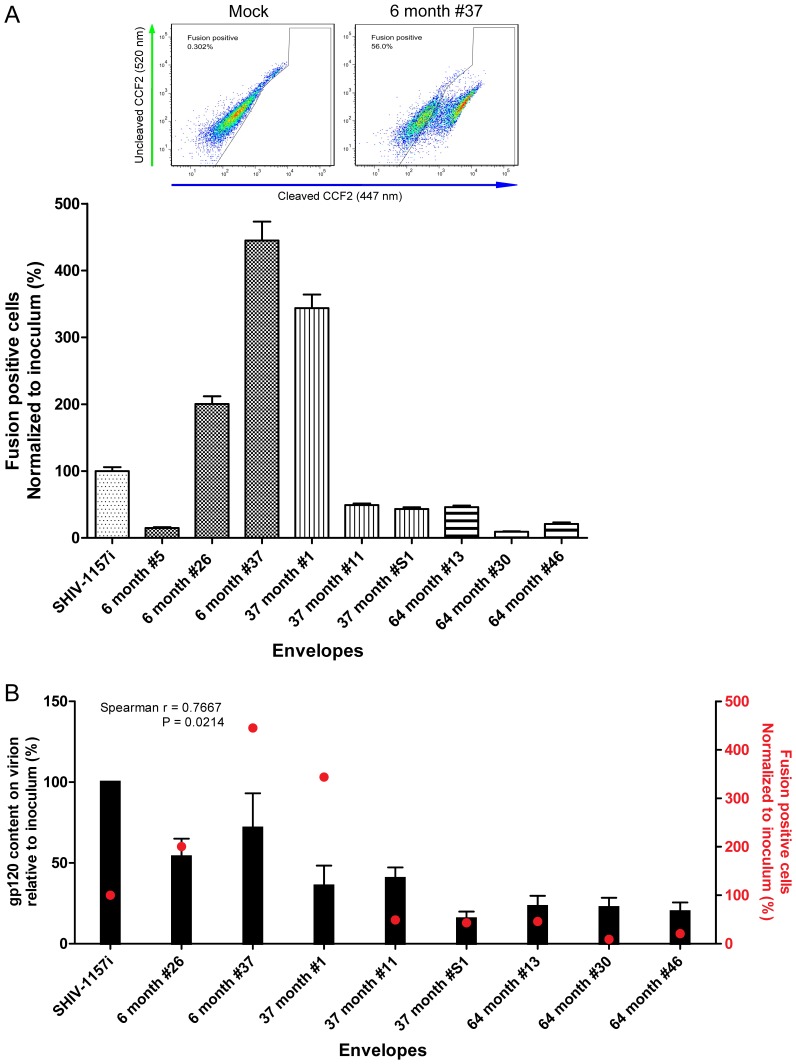
Envelope fusion with target cells was measured using FRET-based virus-to-cell fusion assay.(A) An example for the detection of fluoresce emission shift from green (fusion negative) to blue (fusion positive) by flow cytometry was shown above the graph. The graph shows percentage of fusion-positive cells for individual envelope clones from each time point relative to the inoculum, SHIV-1157i. All differences were statistically significant compared to the inoculum. (B) Correlation between the levels of virion-associated gp120 (black bars) and fusion-positive cells (red dots). The 6 month #5 is excluded from this correlation analysis since it is a CD4 binding site mutant.